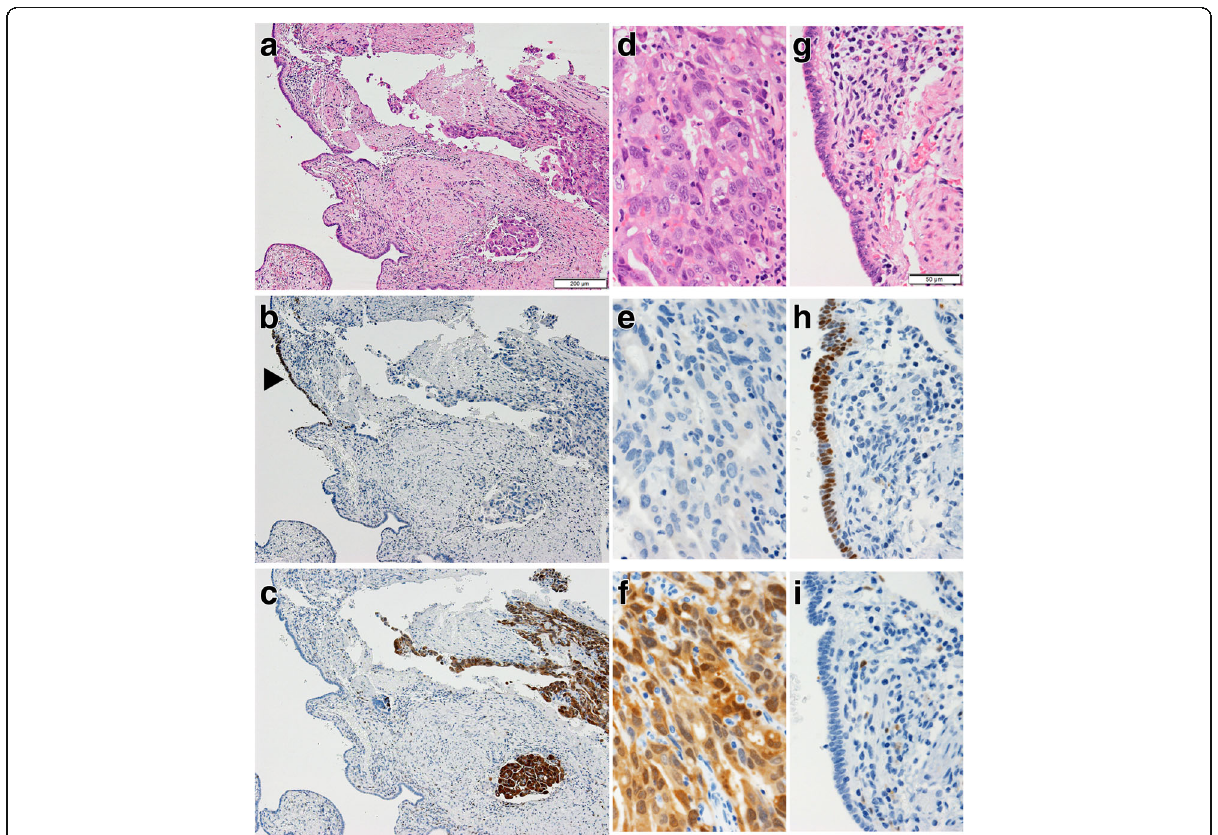
Fig. 1 Two distinctive p53 aberrantly-expressing lesions. ( a )-( c ) Representative hematoxylin and eosin stained ( a ), p53 ( b ) and p16 ( c ) immuno- stained images of the left fallopian tube, which contains high-grade serous carcinoma (right) and p53 signature (left, arrowhead). ( d )-( f ) Represen- tative hematoxylin and eosin stained ( d ), p53 ( e ) and p16 ( f ) immunostained images of high-grade serous carcinoma. ( g )-( i ) Representative hematoxylin and eosin stained ( g ), p53 ( h ) and p16 ( i ) immunostained images of p53